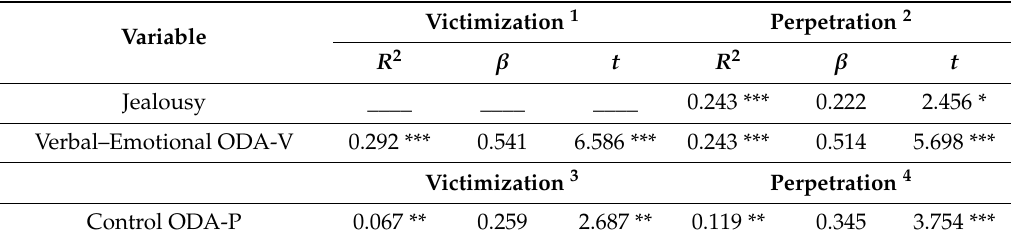
Table 5. Multilinear regression analysis assessing the CDA direct aggression victimization and perpetration